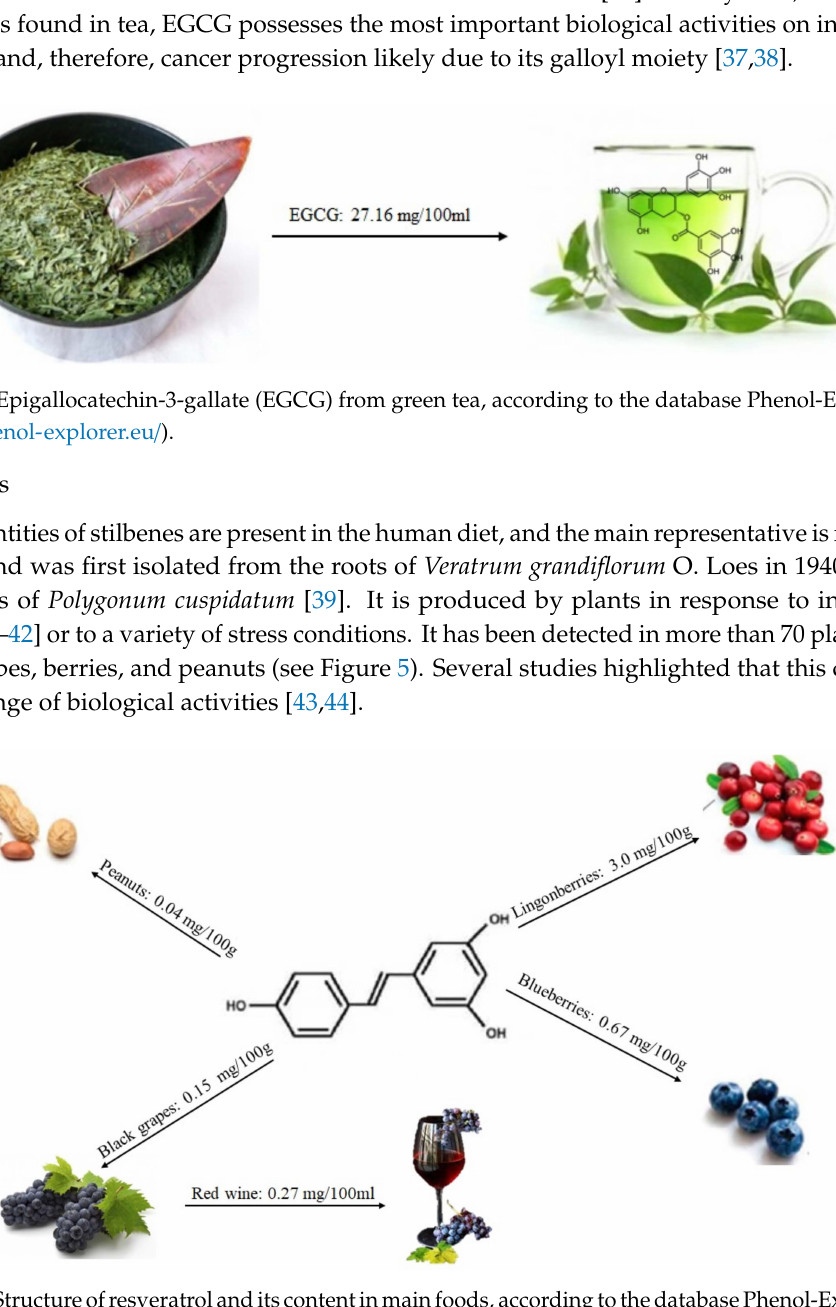
Figure5. Structureofresveratrolanditscontentinmainfoods,